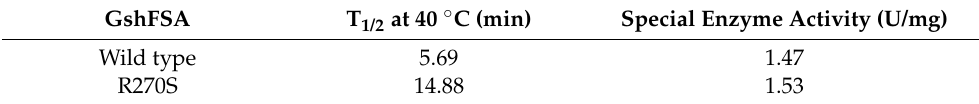
Figure 3. Positive mutants after high-throughput screening. Table 1. Comparison of wild-type and point saturation mutation screening for optimal mutants.